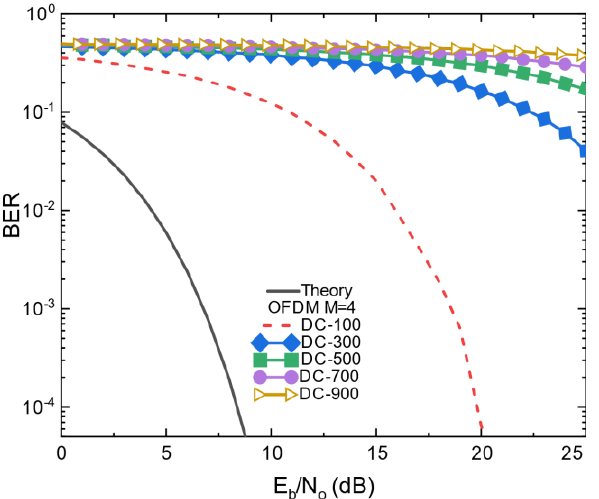
Figure 4. BER performance as a function of E b /N o for OFDM with 4-QAM and 200 AC.